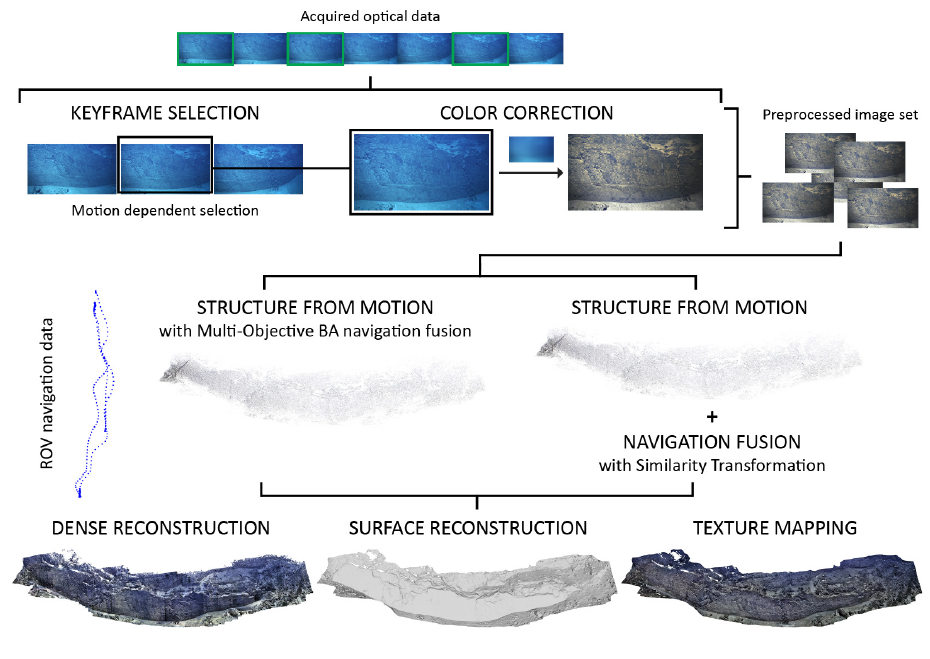
Figure 1. Flowchart of a 3D reconstruction process for underwater applications.